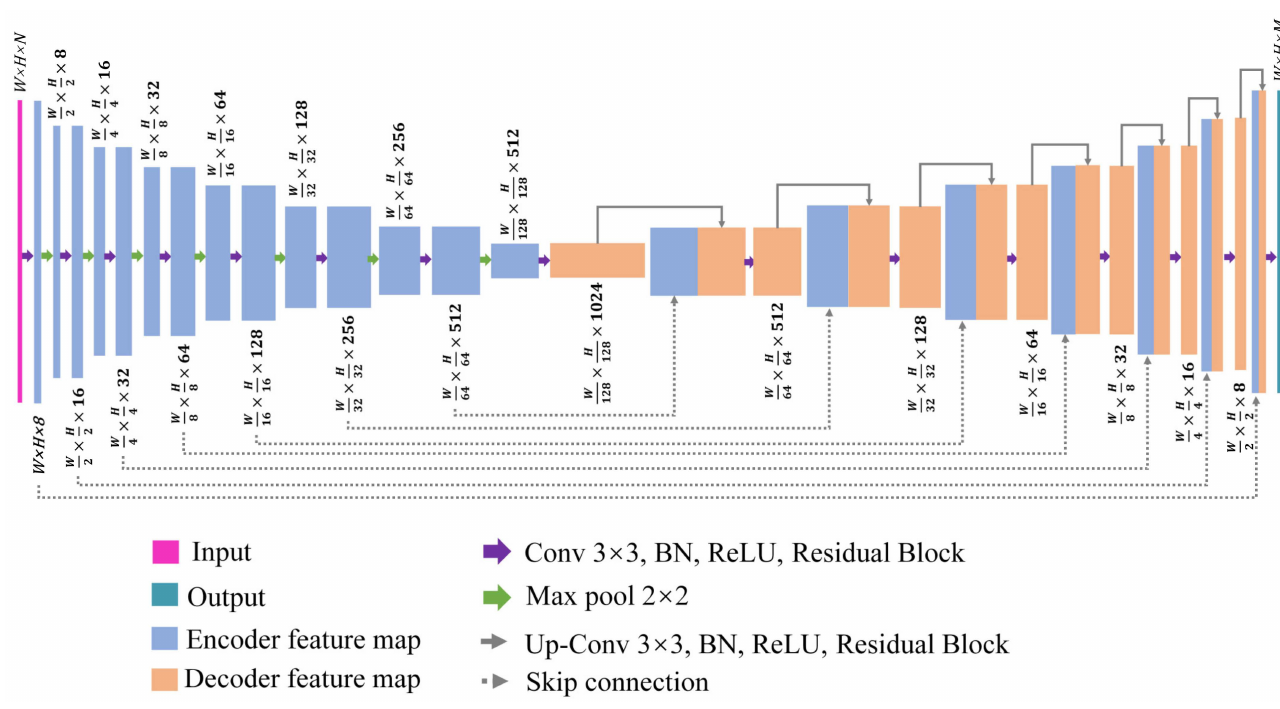
Figure 2. Architecture of the designed DLFT/DLPR network.